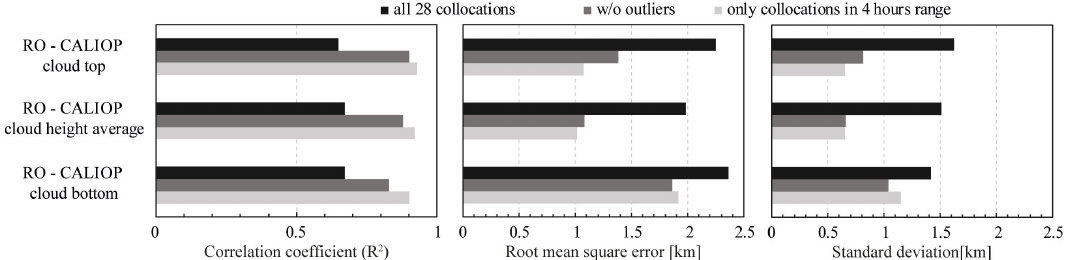
Figure 3. Error estimations. From left to right, the graphs show the correlation coe ffi cient (R 2 ), the root mean square error (rmse), and the standard deviation (std) of the VC altitude estimates from the RO BA anomaly and CALIOP backscatter. Shown are in black the values obtained when we consider all the 28 collocated profiles, in dark gray the values when we exclude the outliers (collocation number 5, 22 and 23), and in light gray the values for collocations within the 4 h